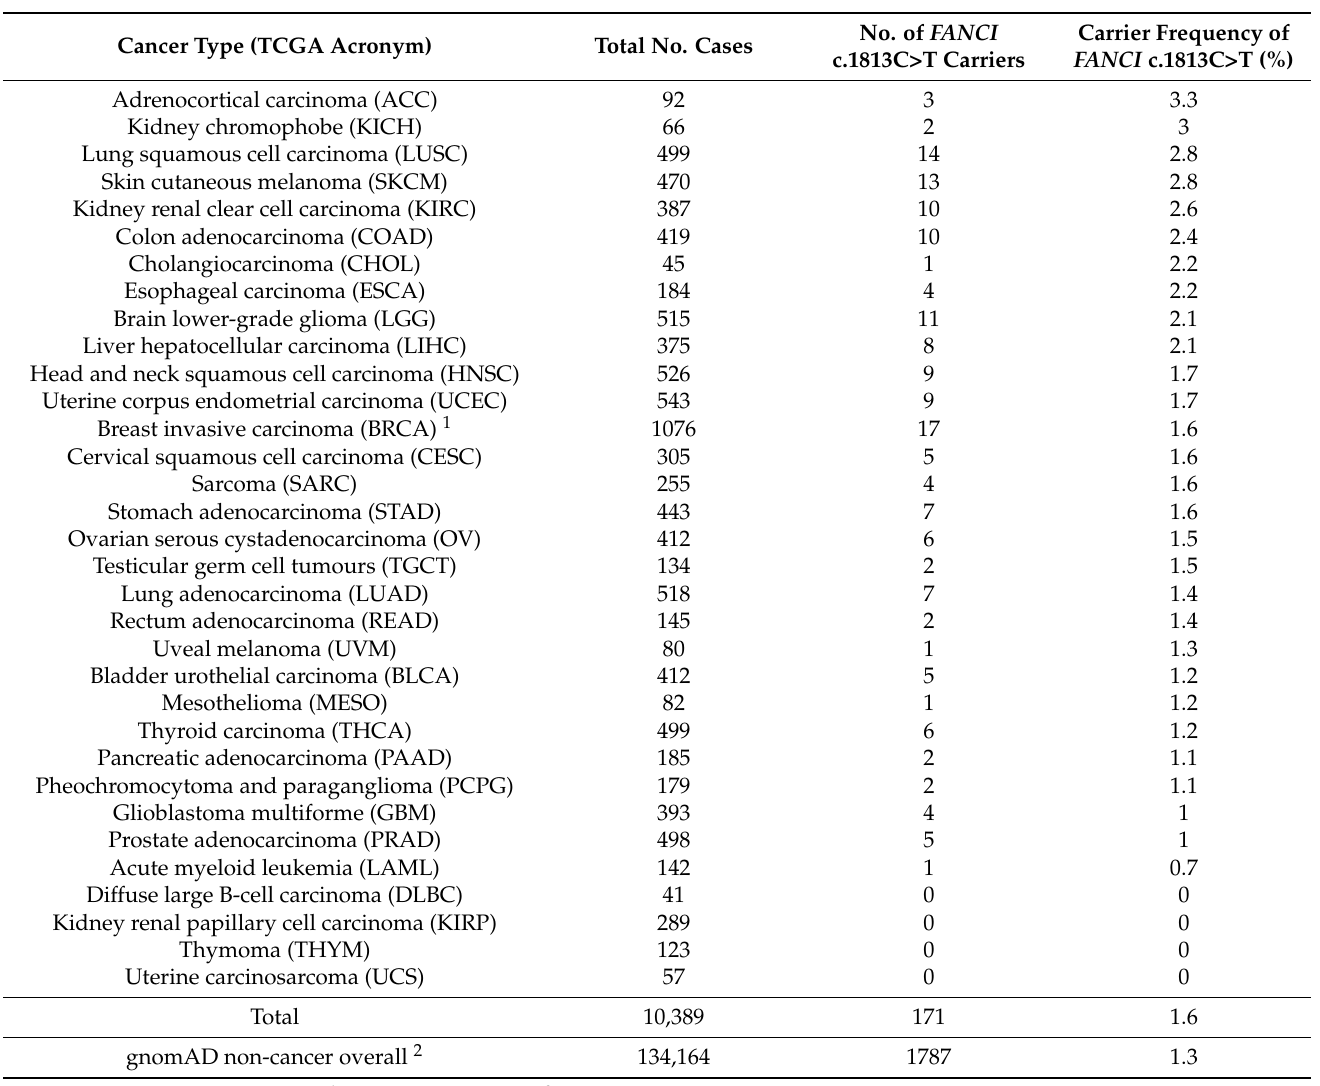
Table 5. Carrier frequency of FANCI c.1813C>T in TCGA PanCancer cases (n =